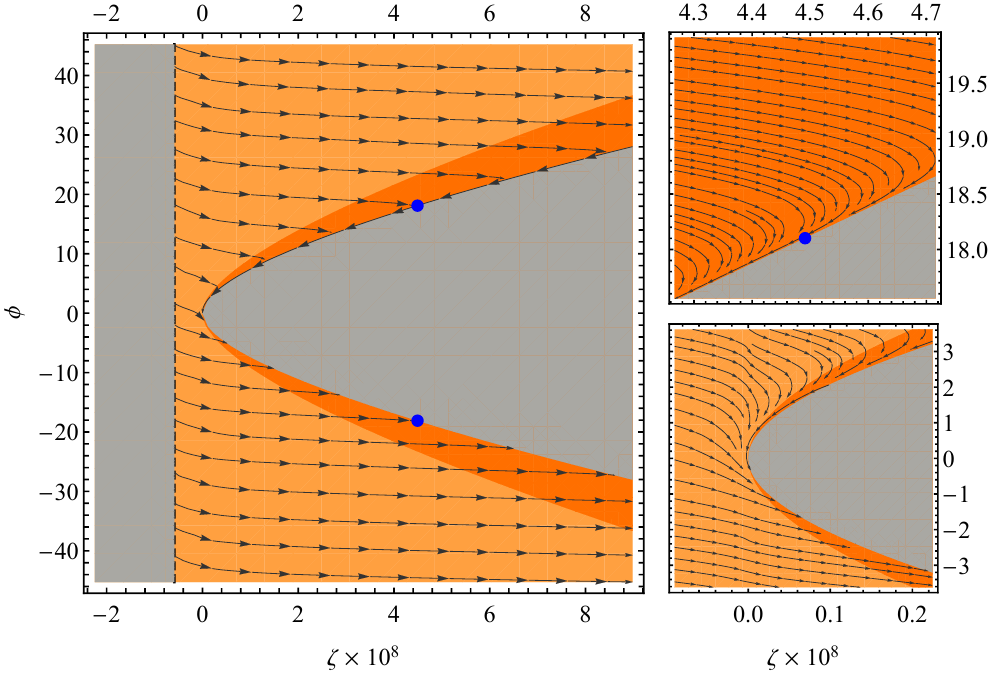
Figure 4. Time evolution of the model (3.1) for the benchmark point in (4.9) in the ( ζ, φ ) plane as given by (4.3), (4.6) (the ˙ φ < 0 , H > 0 branch). The grey areas are excluded because either F 0 ( ζ ) < 0 or (4.3) can’t be satisfied. The darker orange region corresponds to inflation. The blue dots denote the CMB scale with N e = 50 , and have A s = 2 . 1 · 10 − 9 , n s = 0 . 967 , r = 0 . 096 . φ > 0 approach the upper edge, but slow down due to Hubble friction and enter slow-roll right next to the edge on the same branch. This can be seen as sharp turns in the ( ζ, φ ) trajectories in the top right panel of figure 4. Note that two more branches, with H < 0 , can be obtained by simply switching the direction of the flow; these can’t be reached smoothly from the inflating branches in a spatially flat universe filled only with a scalar